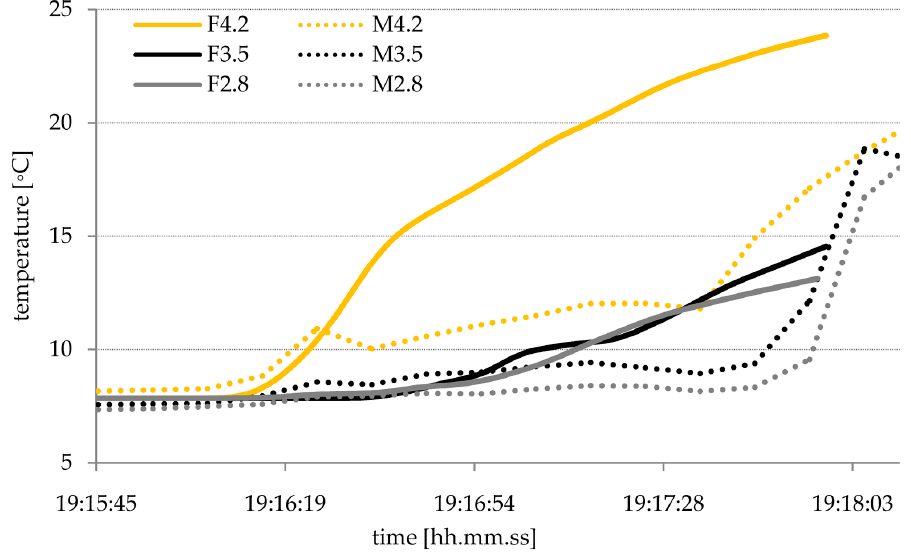
Figure 11. Temperature increase on windward at 10 m from the last tray. Prefix M denotes measurement, prefix F denotes Fluent calculation.